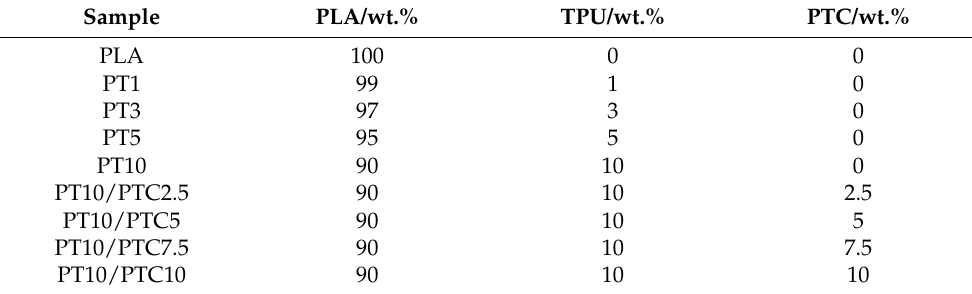
Table 1. Formulation of PLA/TPU and PLA/TPU/PTC